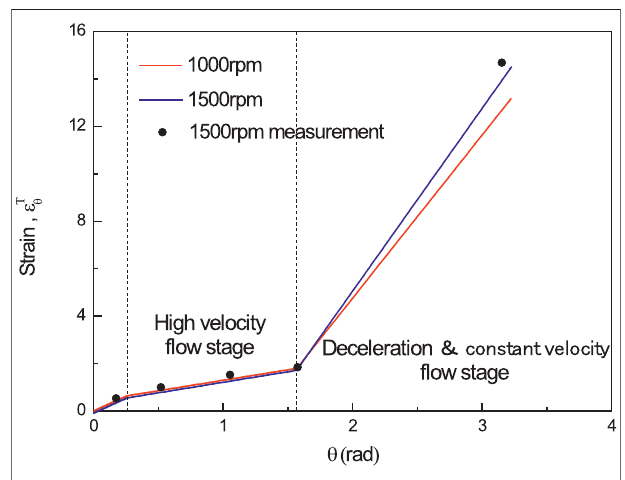
FIGURE 10 | Changes of the strain at different parameters of